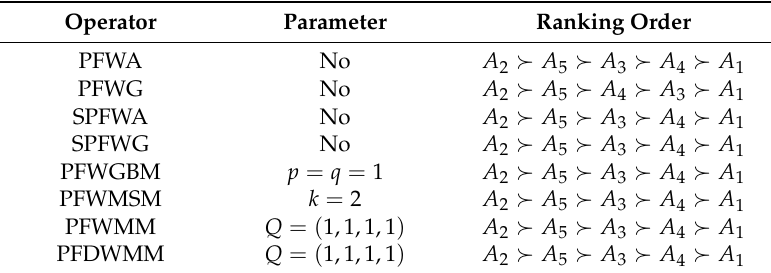
Table 13. Ranking order of alternatives obtained by different